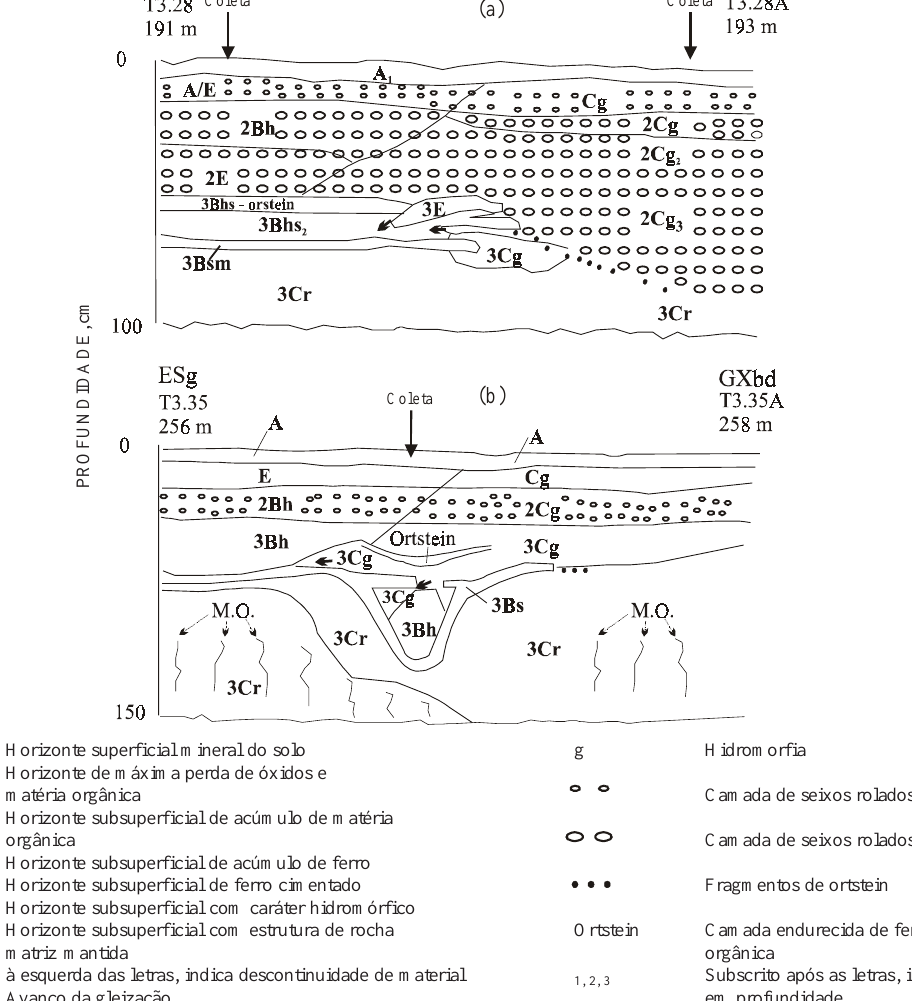
Figura 4. Perfis representando a passagem do solo Espodossolo para Gleissolo. (a) passagem abrupta T3.28 para T3.28A; (b) detalhes da transformação T3.35 e